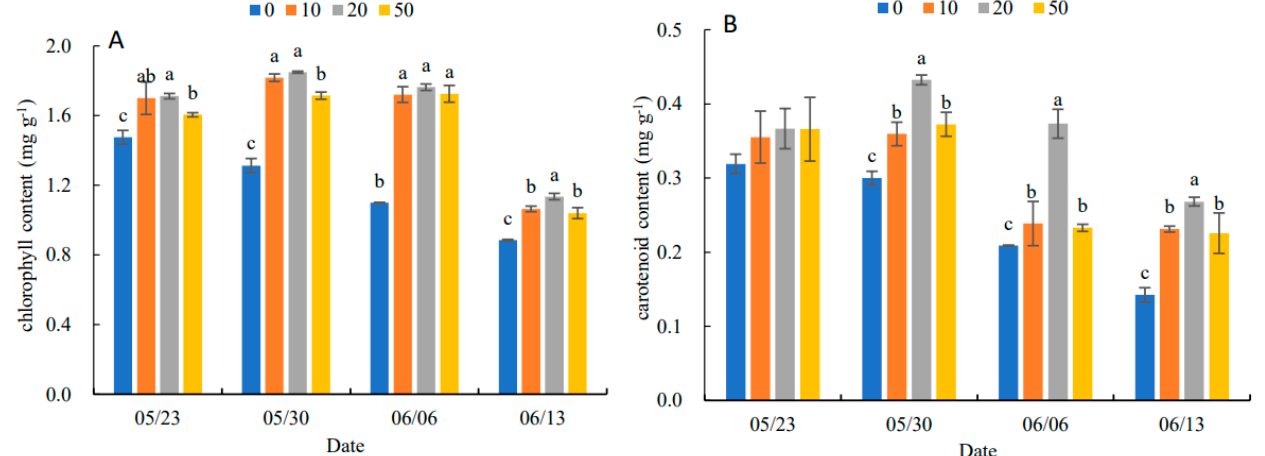
Figure 2. Effects of different concentrations of 5-ALA on chlorophyll content ( A ) and carotenoid content ( B ) of P. heterophylla leaves during senescence from 23 May to 13 June. Data show the mean with standard deviation bar of three replicates from samples. Different letters indicate a significant difference at 0.05 level between different treatments.